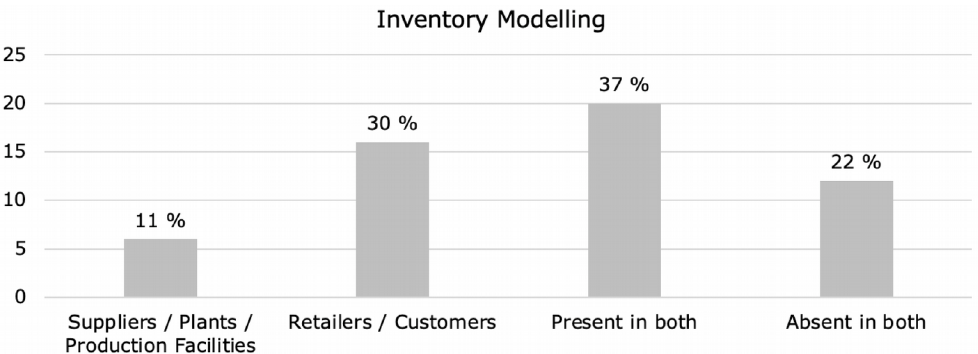
Figure 8. Statistics on supply chain structure: Inventory Modelling